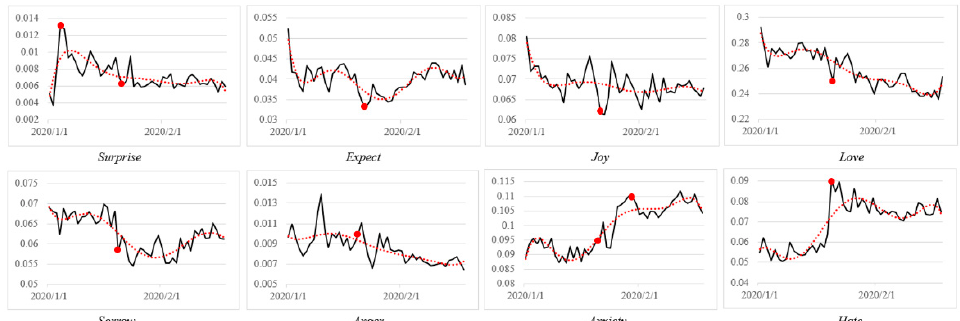
Figure 6. Eight Emotional Volatilities in January and February.